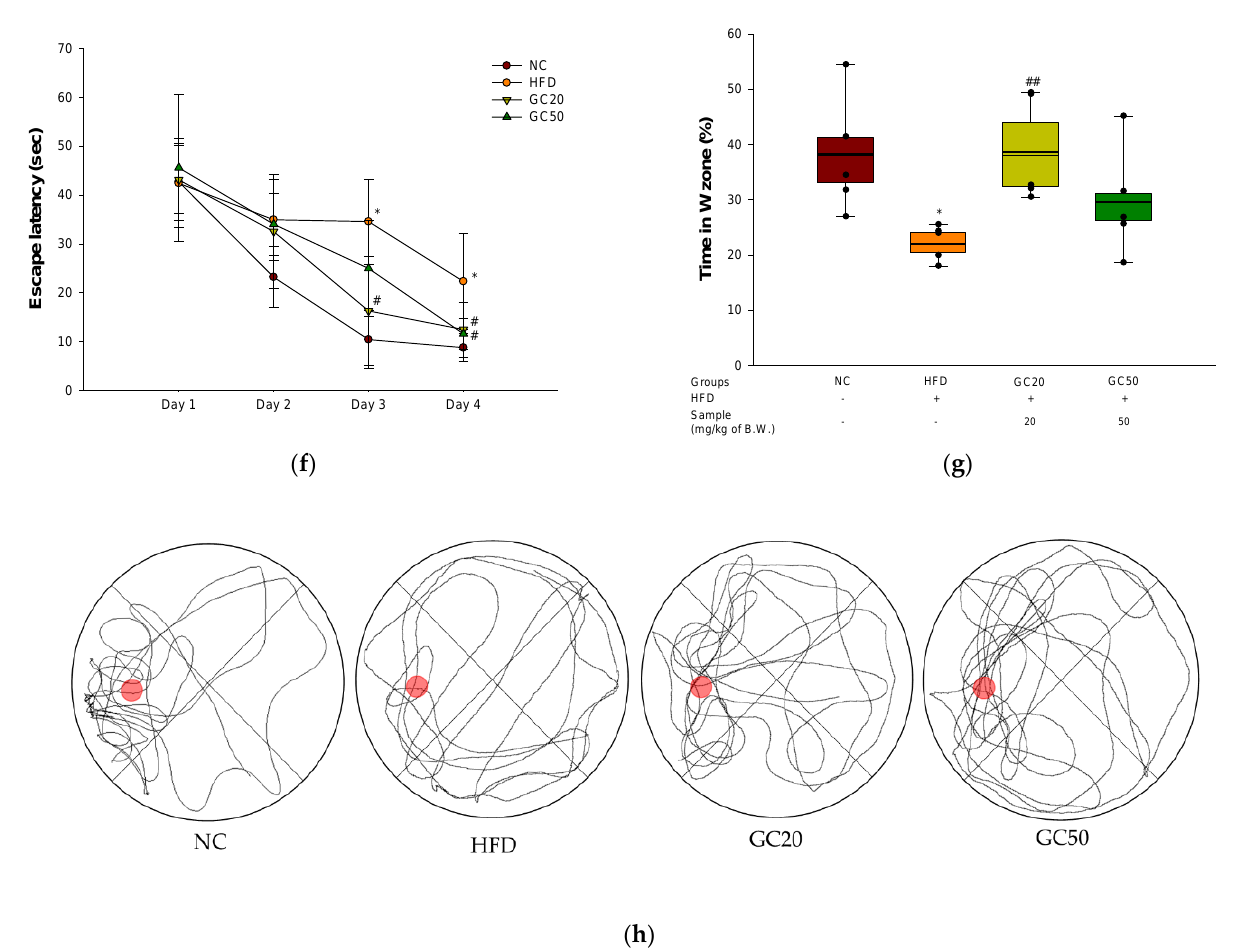
Figure 5. Protective of 80% ethanolic extract from Gimcheon 1ho (GC) cultivar walnut ( Juglans regia ) in HFD-induced mice: ( a ) a number of arm entries; ( b ) spontaneous alternation behavior; ( c ) 3D moving routes in Y-maze test; ( d ) latency during habituation; ( e ) step-through latency in passive avoidance test; ( f ) escape latency in the hidden test; ( g ) retention time in W zone; ( h ) path tracing of each group in Morris water maze (MWM) test. Results shown are mean ± SD ( n = 5). Data are statistically represented with * = significantly different from the NC group, and # = significantly different from PM group; * and # p < 0.05, ** and ## p < 0.01. Bold line indicates mean.